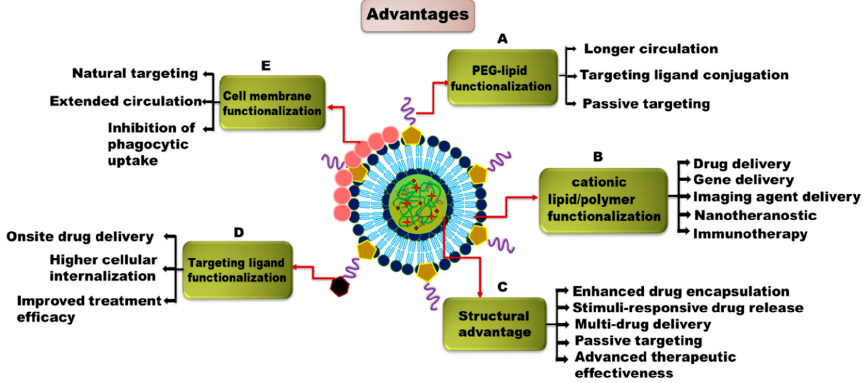
Figure 3. Schematic representation of advantages of different PLHNPs. ( A ) Polyethylene glycol (PEG) ‐ lipid functionalization of PLHNPs prolongs the systemic circulation in the